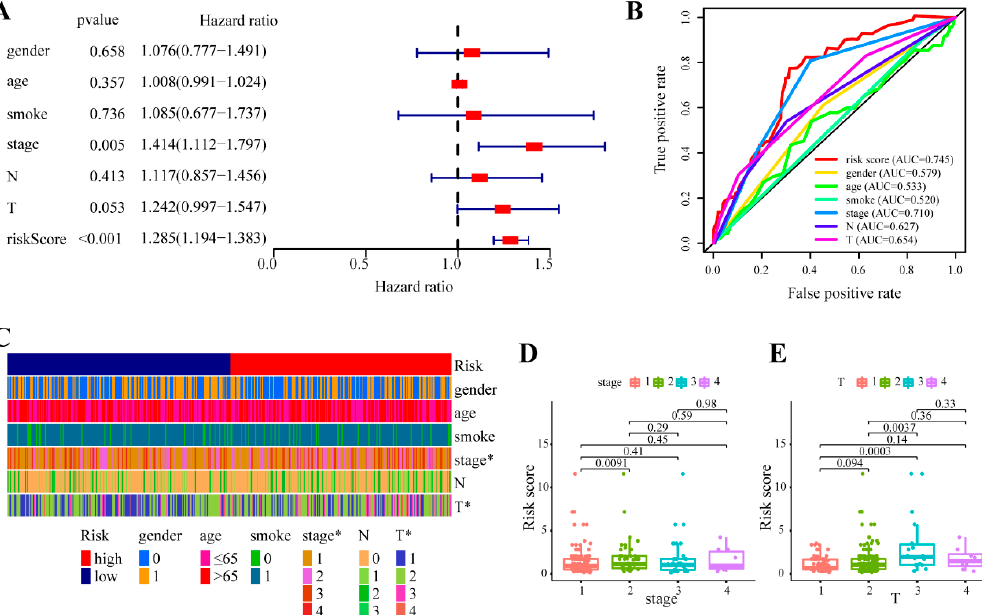
Figure 4. Relationship between the risk score and clinical variables. ( A ) The forest map shows the risk score and of the clinical variables. ( B ) ROC curves of the risk score and clinical variables for overall survival in the TCGA total dataset. ( C ) The heatmap of the clinicopathological data of patients between the low- and high-risk groups. The boxplots depict the relationship between the risk score and ( D ) clinical stage and ( E ) T stage. (* p < 0.05).